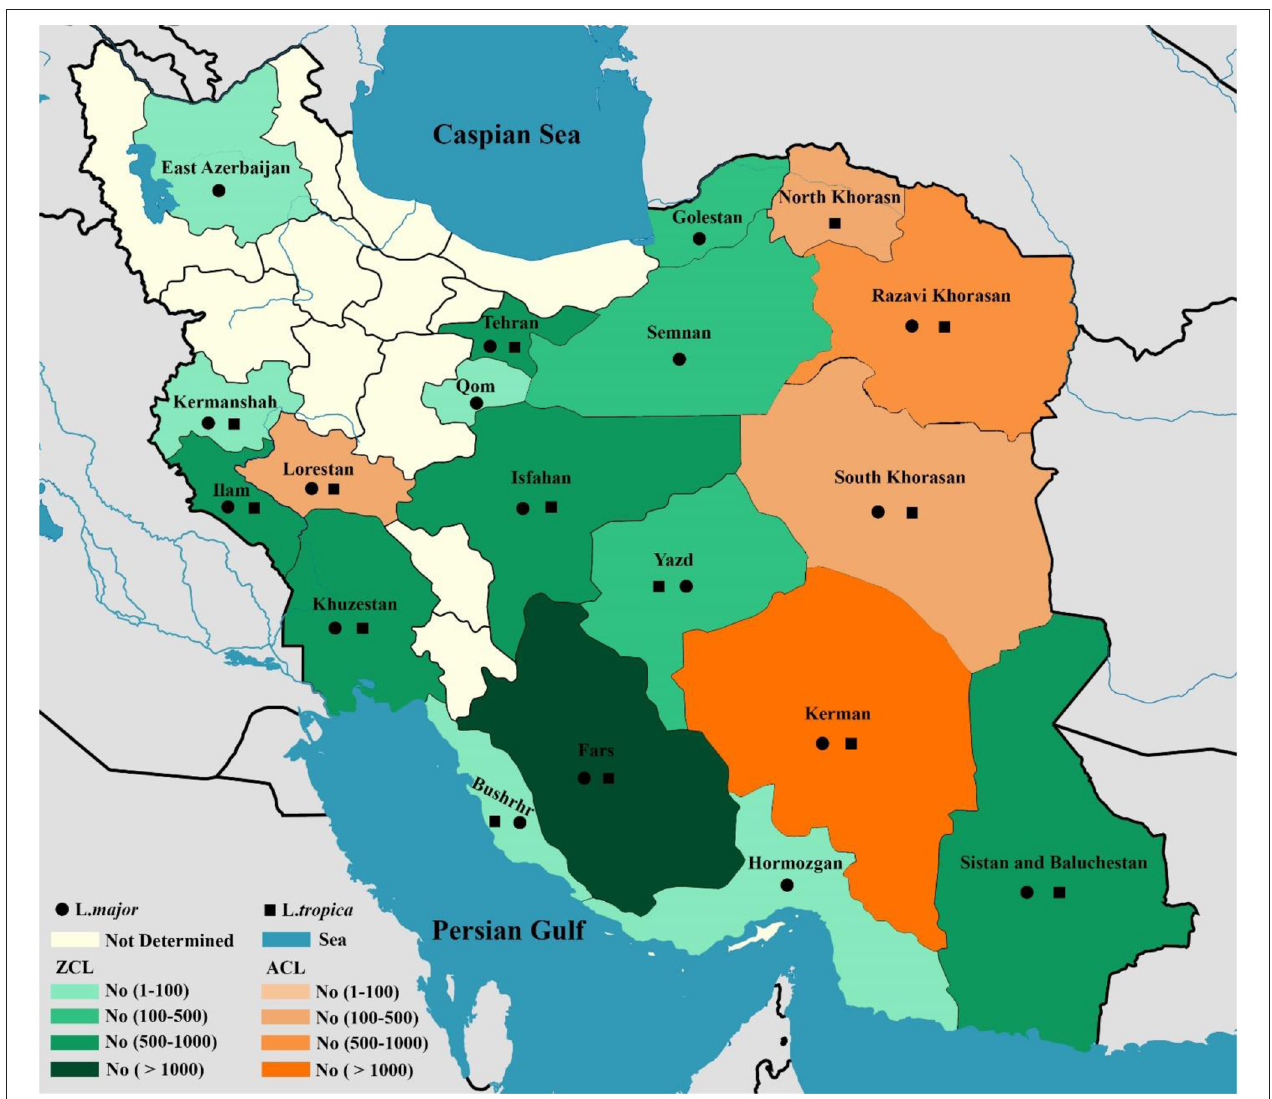
FIGURE 2 | Map of distribution of Leishmania spp. causing ZCL and ACL using molecular methods in different geographical areas of